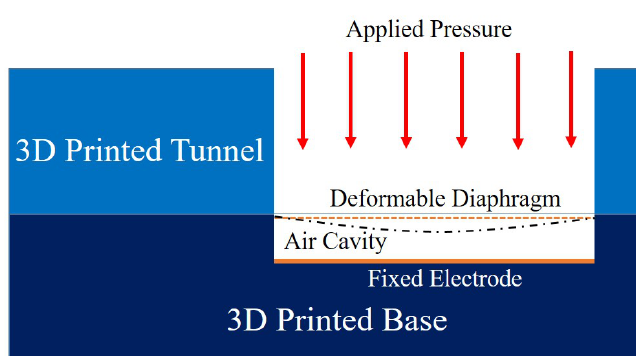
Figure 2. Air cavity-based fully 3D printed pressure sensor.